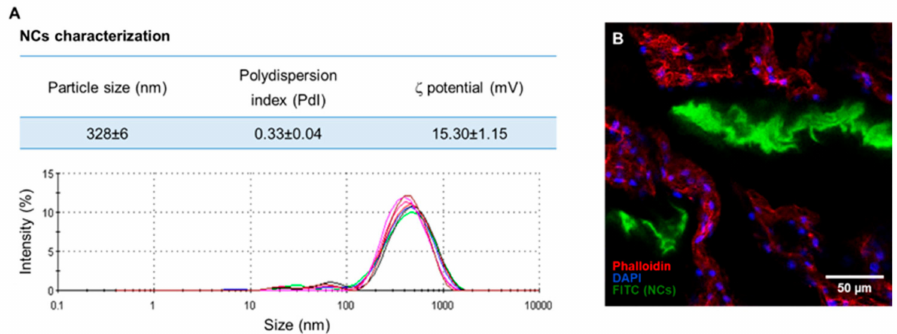
Figure A1. ( A ) Characterization of the size dispersion of di ff erent nanocomplexes solutions, analyzed by dynamic and electrophoretic light scattering (DLS). Particle size distribution plots obtained by intensity of the scattered light, n = 6. ( B ) ftNCs injected into the rat IVDs (ftNCs in green, cell nuclei in blue and cell cytoskeleton in red; scale bar: 50 µ m).